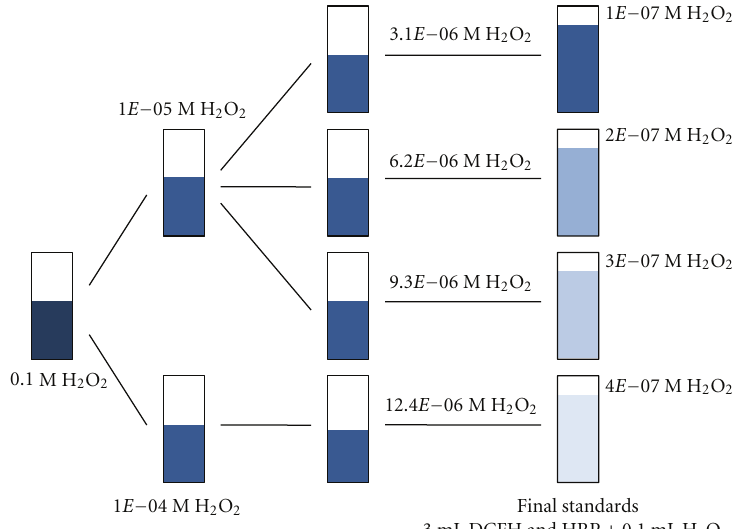
Figure 2: Standard H 2 O 2 preparation process.